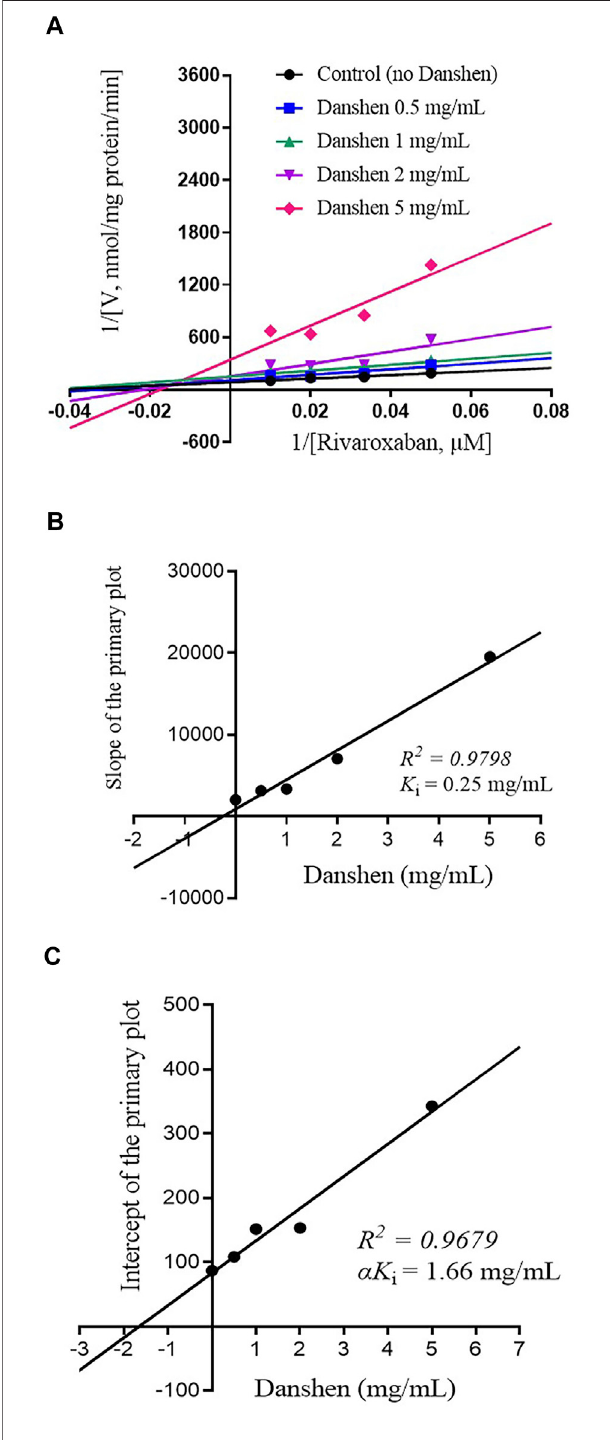
FIGURE 3 | Primary Lineweaver – Burk plot (A) , the secondary plot for K i (B) , and the secondary plot for α K i (C) for the inhibition of rivaroxaban metabolism by Danshen tablet with various concentrations (0.5, 1, 2, and 5 mg/mL) in HLM. Rivaroxaban was used at 20, 30, 50, and 100 μ M. Each data point represents the mean of quadruplicate